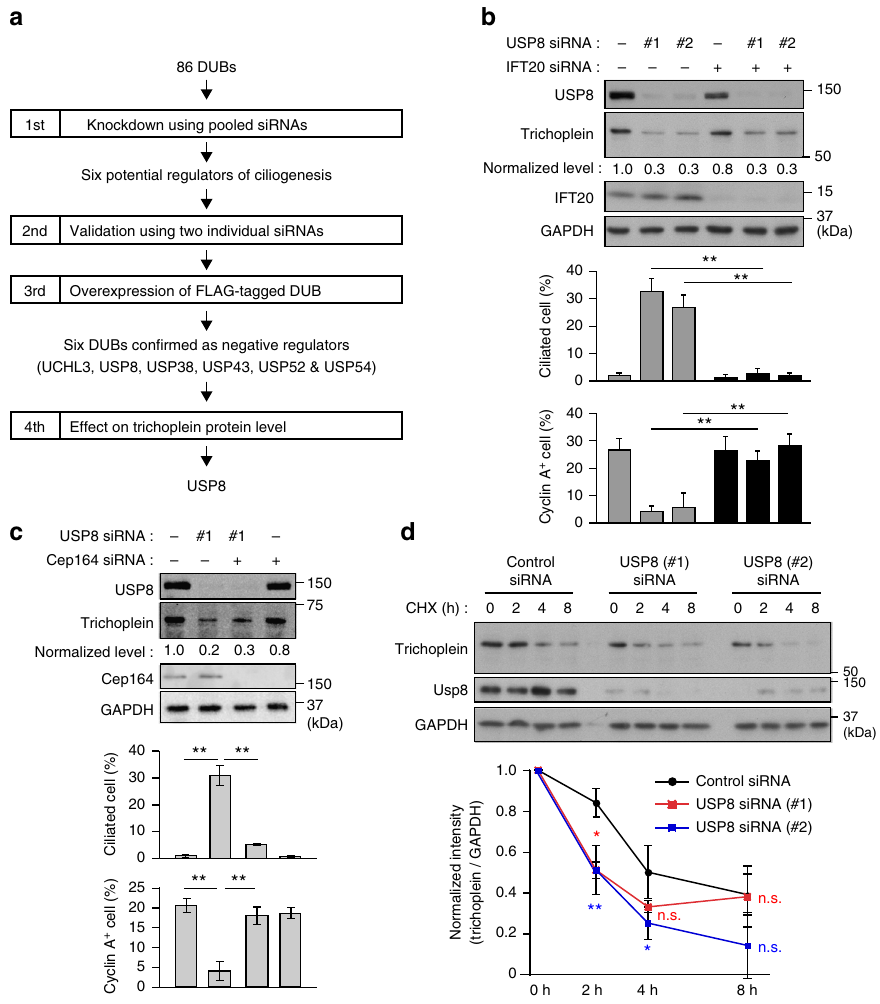
Fig. 1 USP8 knockdown induces trichoplein degradation and unscheduled ciliogenesis. a Screen fl owchart. b , c Twenty-four hours after transfection with siRNA for IFT20 ( b ) or Cep164 ( c ), PRE1 cells were further transfected with USP8 siRNA (#1 or #2) and then cultured for 48 h in the presence of serum (10% FBS). The cells were analyzed by immunoblotting with indicated antibodies. Normalized intensities of trichoplein/GAPDH are shown as mean from three independent biological replicates. Percentages of ciliated cells and cyclin A-positive cells are shown as mean ± SD from three independent biological replicates ( n > 200 each). d Control or USP8 (#1 or #2) knockdown RPE1 cells were treated with 200 nM cycloheximide-supplemented normal medium (10% FBS) for indicated times. Normalized intensities of trichoplein/GAPDH (mean ± SD from three independent technical replicates) were evaluated by immunoblotting analysis. To accurately evaluate the kinetics of trichoplein turnover, the samples were re-evaluated in Supplementary Fig. 4a. ** p < 0.01, *0.01 < p < 0.05, n.s. not signi fi cant, two-tailed unpaired student ’ s t